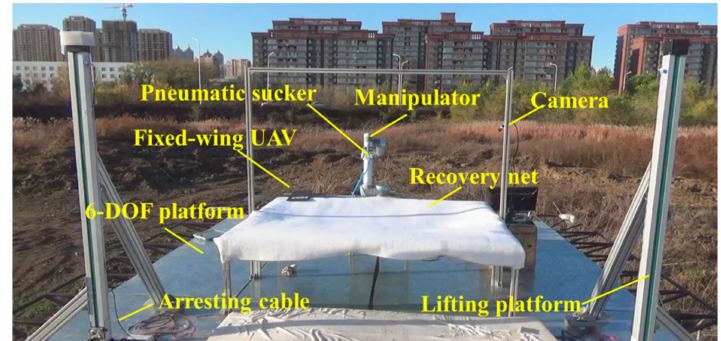
Figure 11. Physical simulation system.